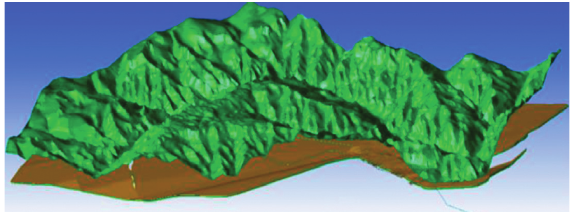
Figure 1: Geological model of Tiaoshuihe phosphate mine.